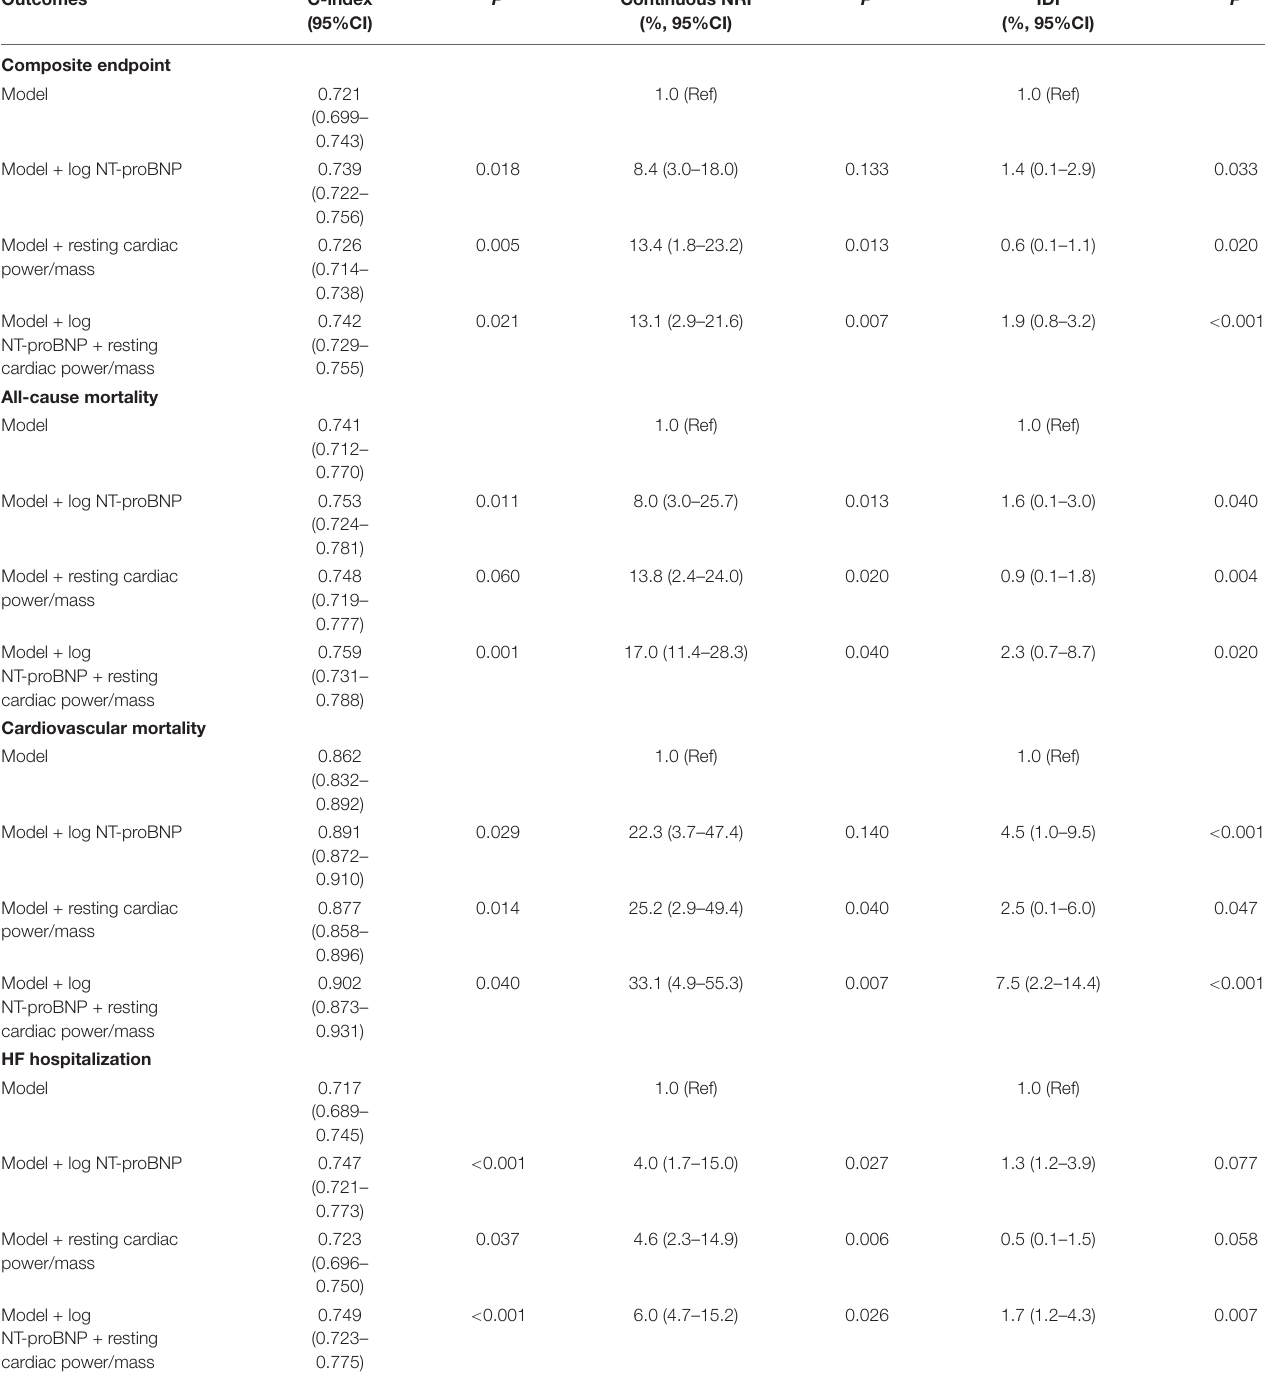
TABLE 3 | Reclassification and discrimination statistics for outcomes by resting cardiac